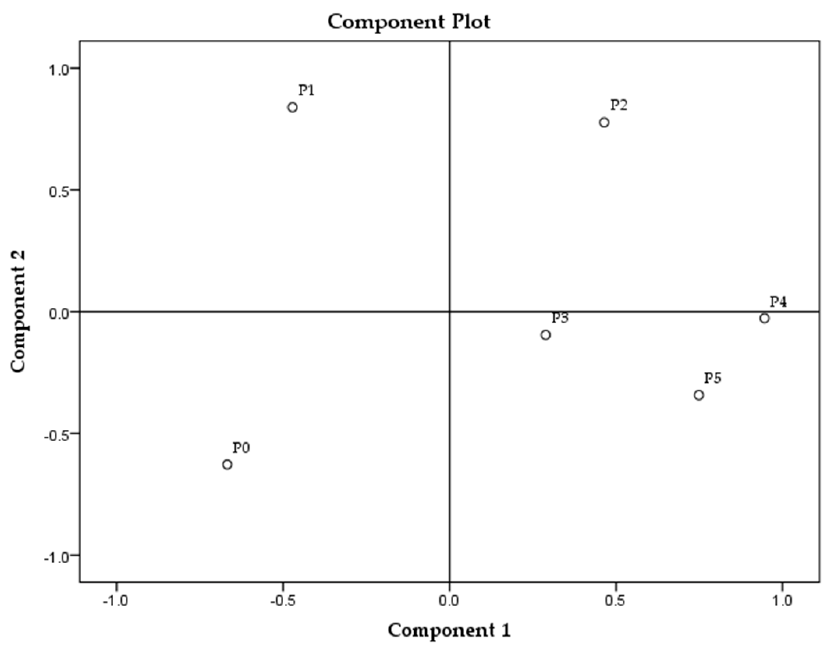
Figure 4. Principal component analysis of soap samples made of palm oil. * Samples’ description is given in Table 1.